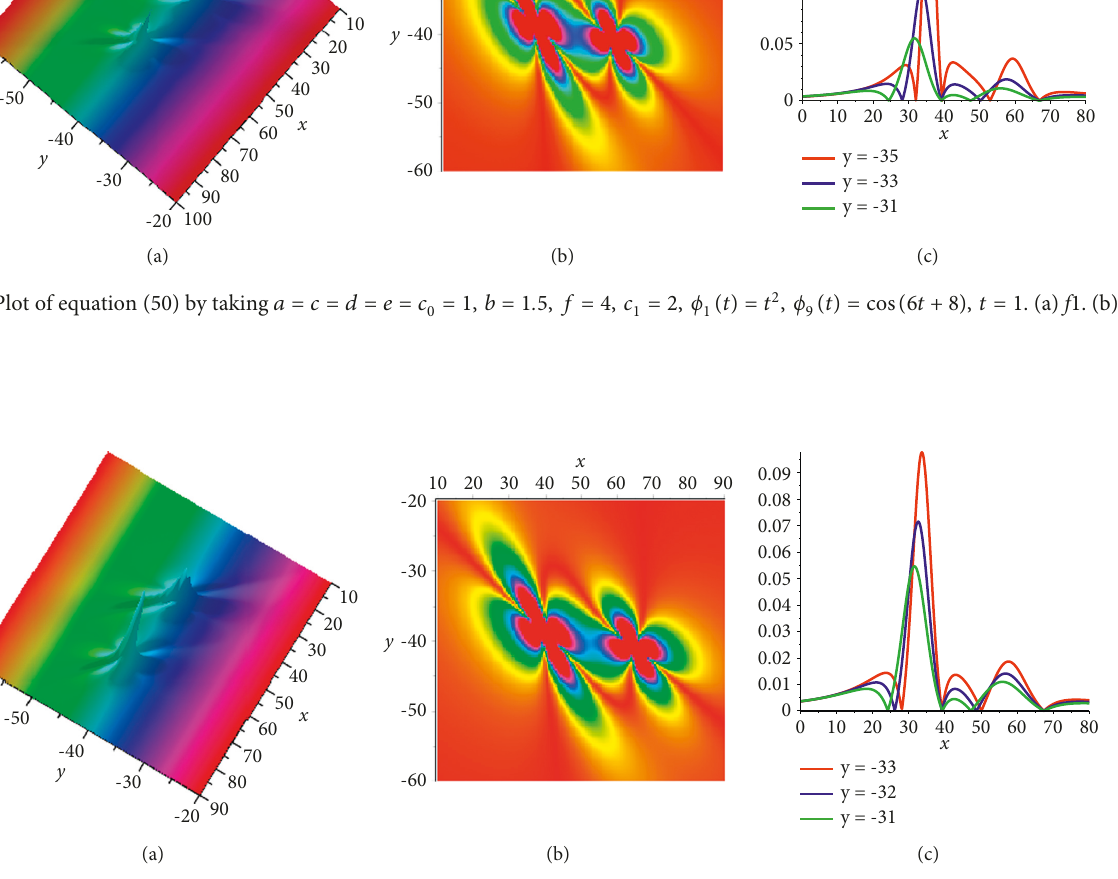
� 1 , b � 1 . 5 , e � f � c 0